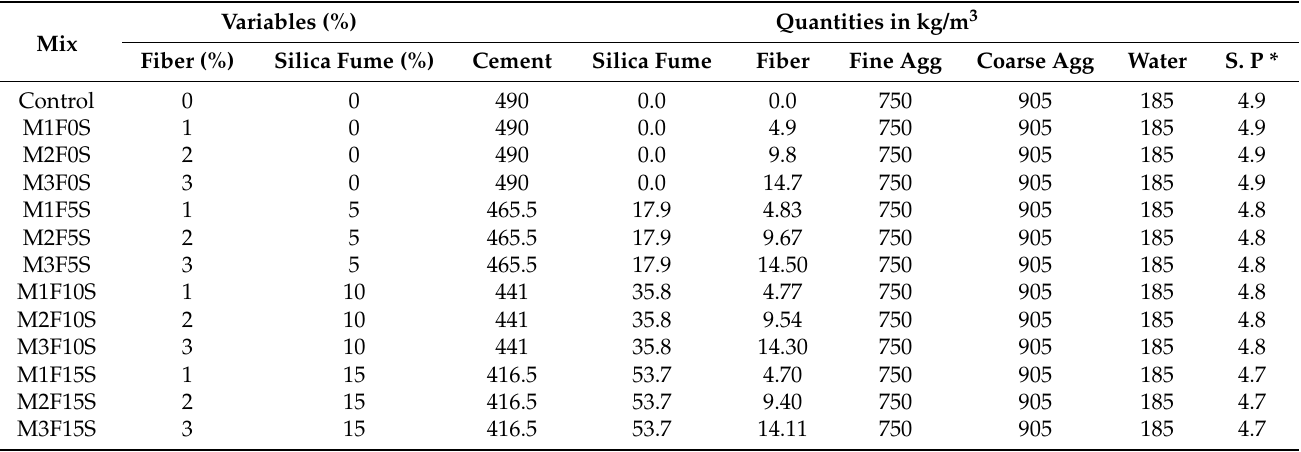
Table 3. Properties of DPF